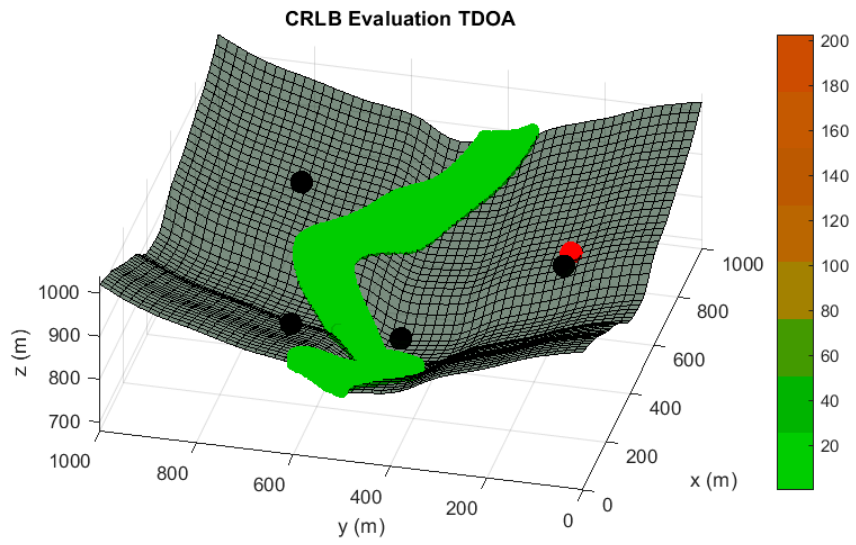
Figure 5. Accuracy analysis in terms of CRLB in meters for the optimized distribution of 5 sensors under possible failure. The condition represented corresponds with the Case I - Sensor Fail 1 of Table 3. Red tones in the color bar indicate badly accuracy evaluations, while green tones imply acceptable accuracy values.